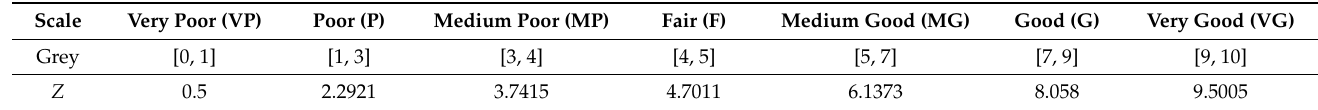
Table 9. The GEPs of the grey linguistic